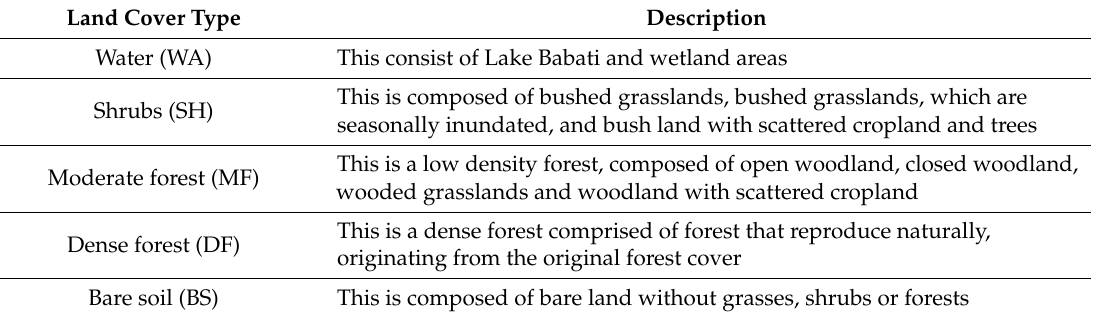
Table 1. Characteristics of selected land cover classes and vegetation